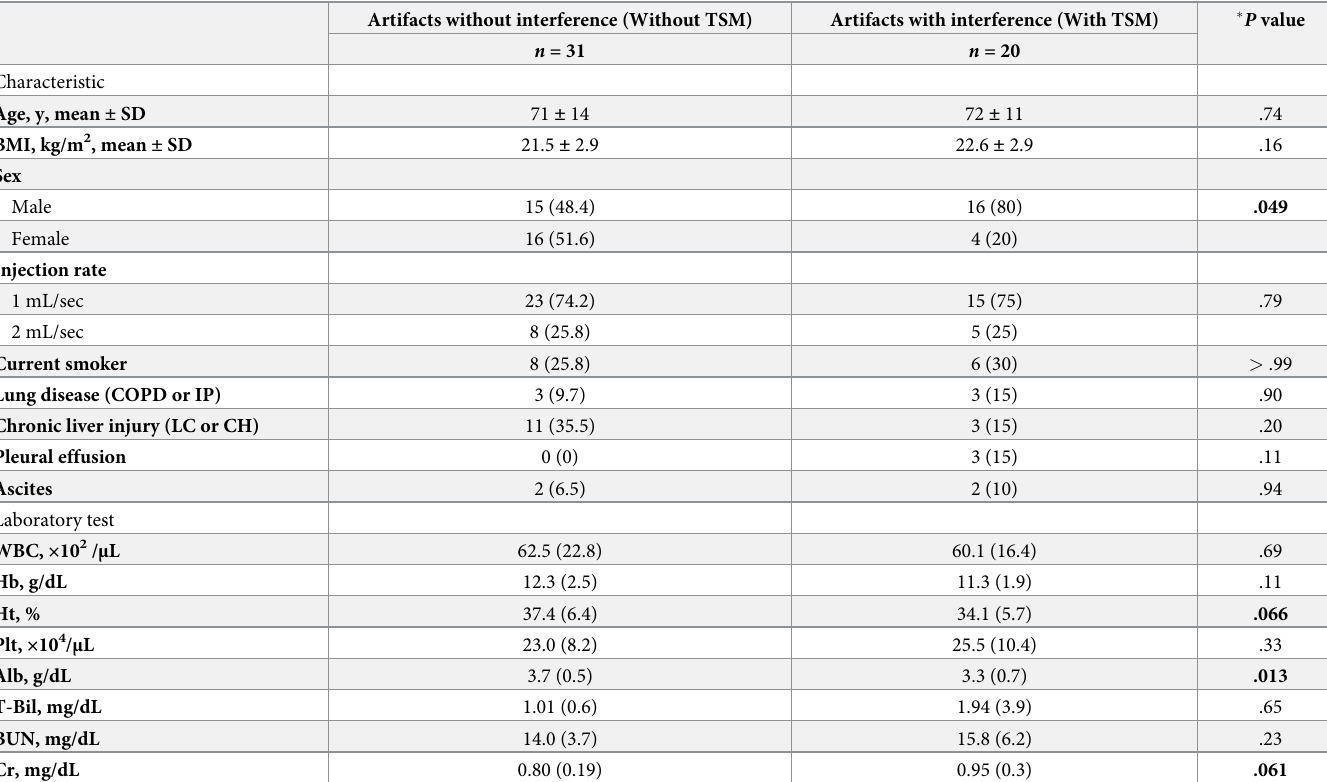
Table 1. Comparisons of clinical characteristics and laboratory test results between patients with and without